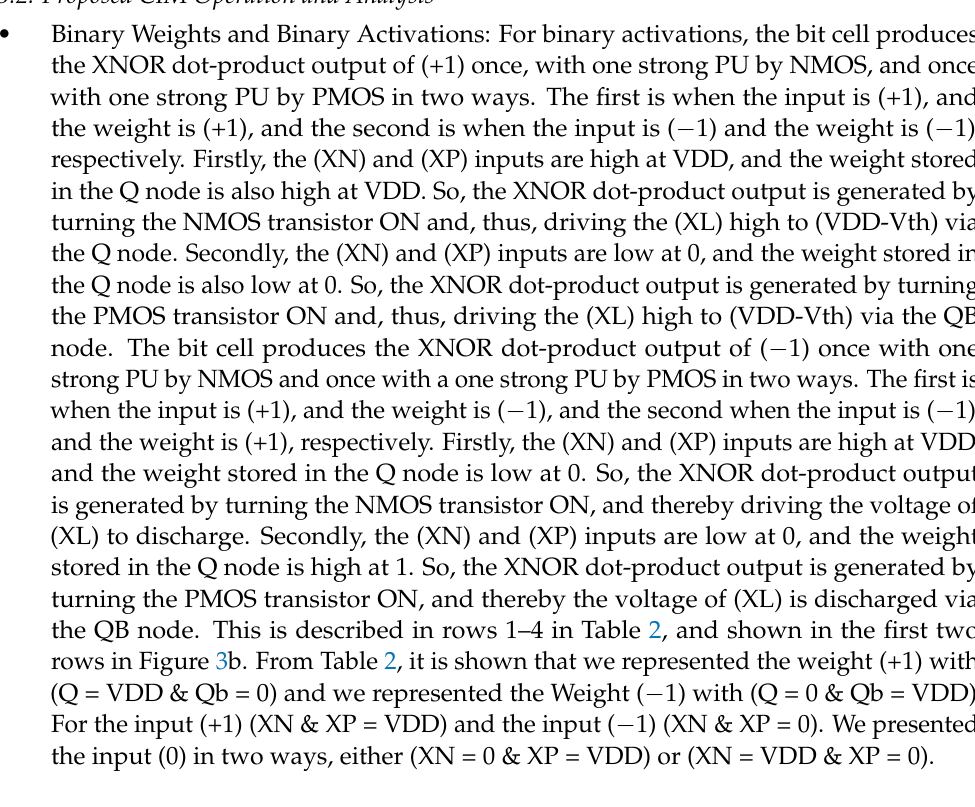
Table 2. Logic map for the Product between the Input and the